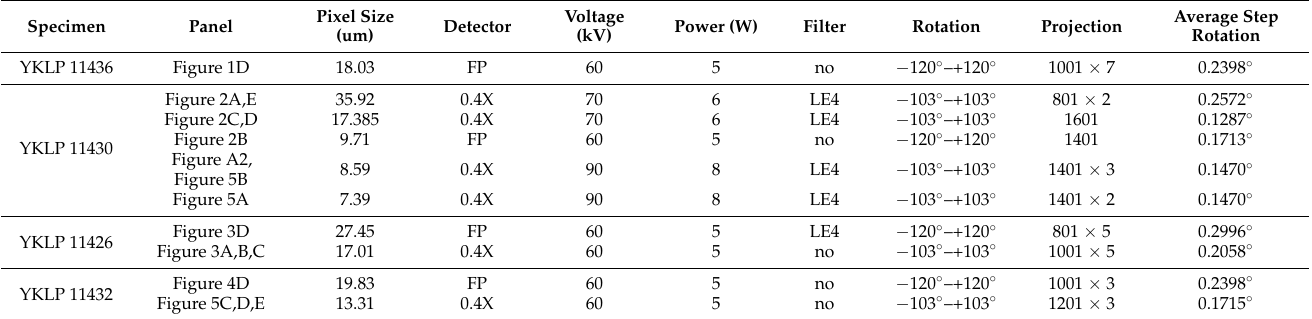
Table 1. Tomography parameters for the following specimens: YKLP 11430, YKLP 11426, YKLP 11432 and YKLP